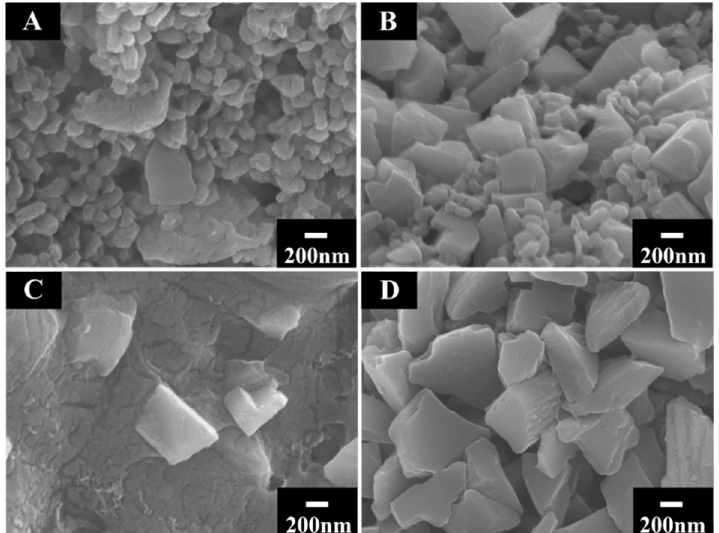
Figure 8. SEM data for films ( A , B ) before and ( C , D ) after annealing (1 h at 350 °C), for films prepared from 1 gL ⁻ 1 CBXNa 2 solutions with 5 gL ⁻ 1 PTFE with ( A , C ) 0.5 gL ⁻ 1 and ( B , D ) 1 gL ⁻ 1 diamond at 50 V.